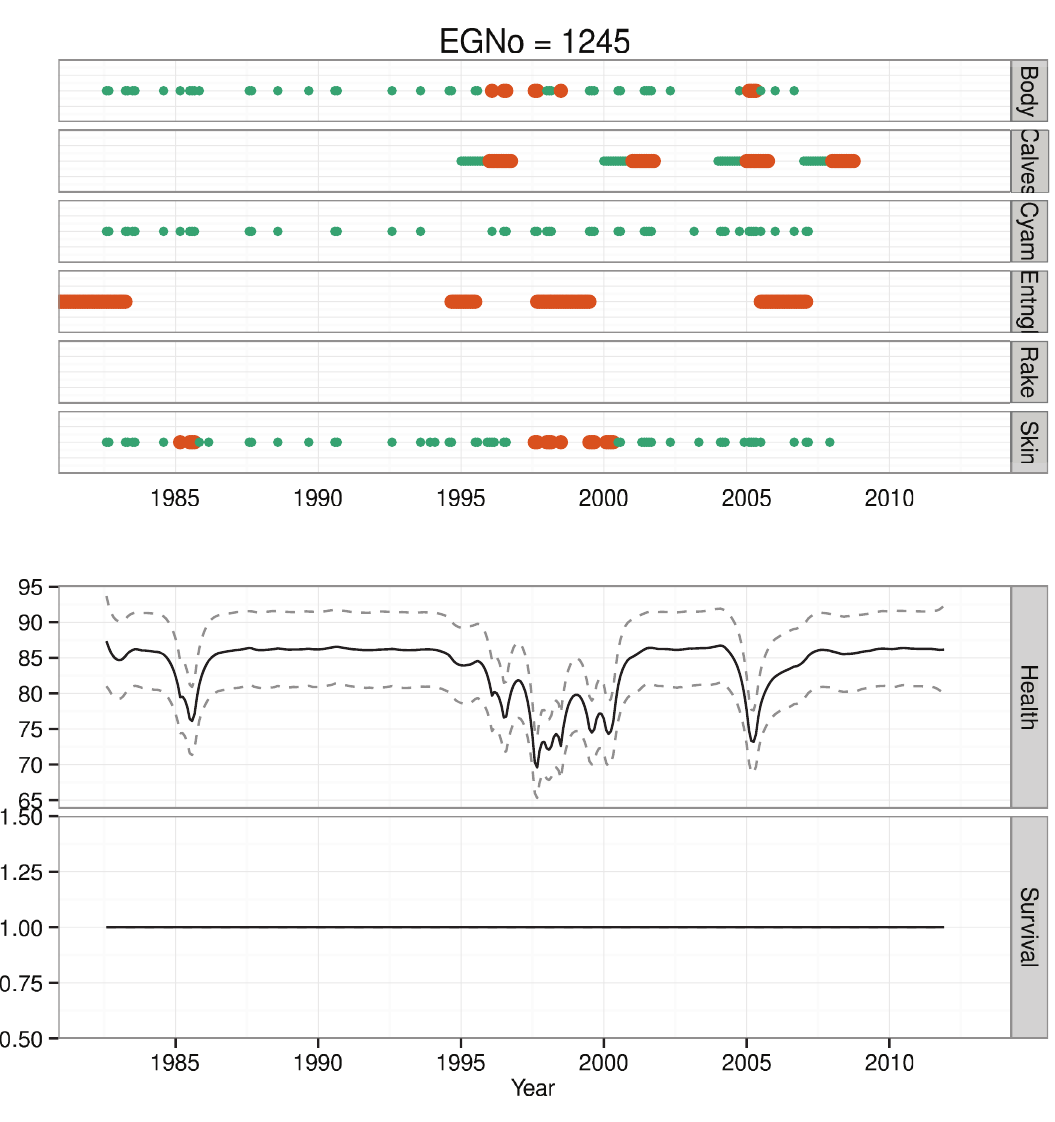
Figure 9. Health time series for whale # 1245. Photographic observations of H are color and size coded as in Figure 8. Additional health observations H , include periods of entanglement, and calving status. # 1245 has experienced several periods of compromised health, but has recovered from each, and is currently imputed to be alive.